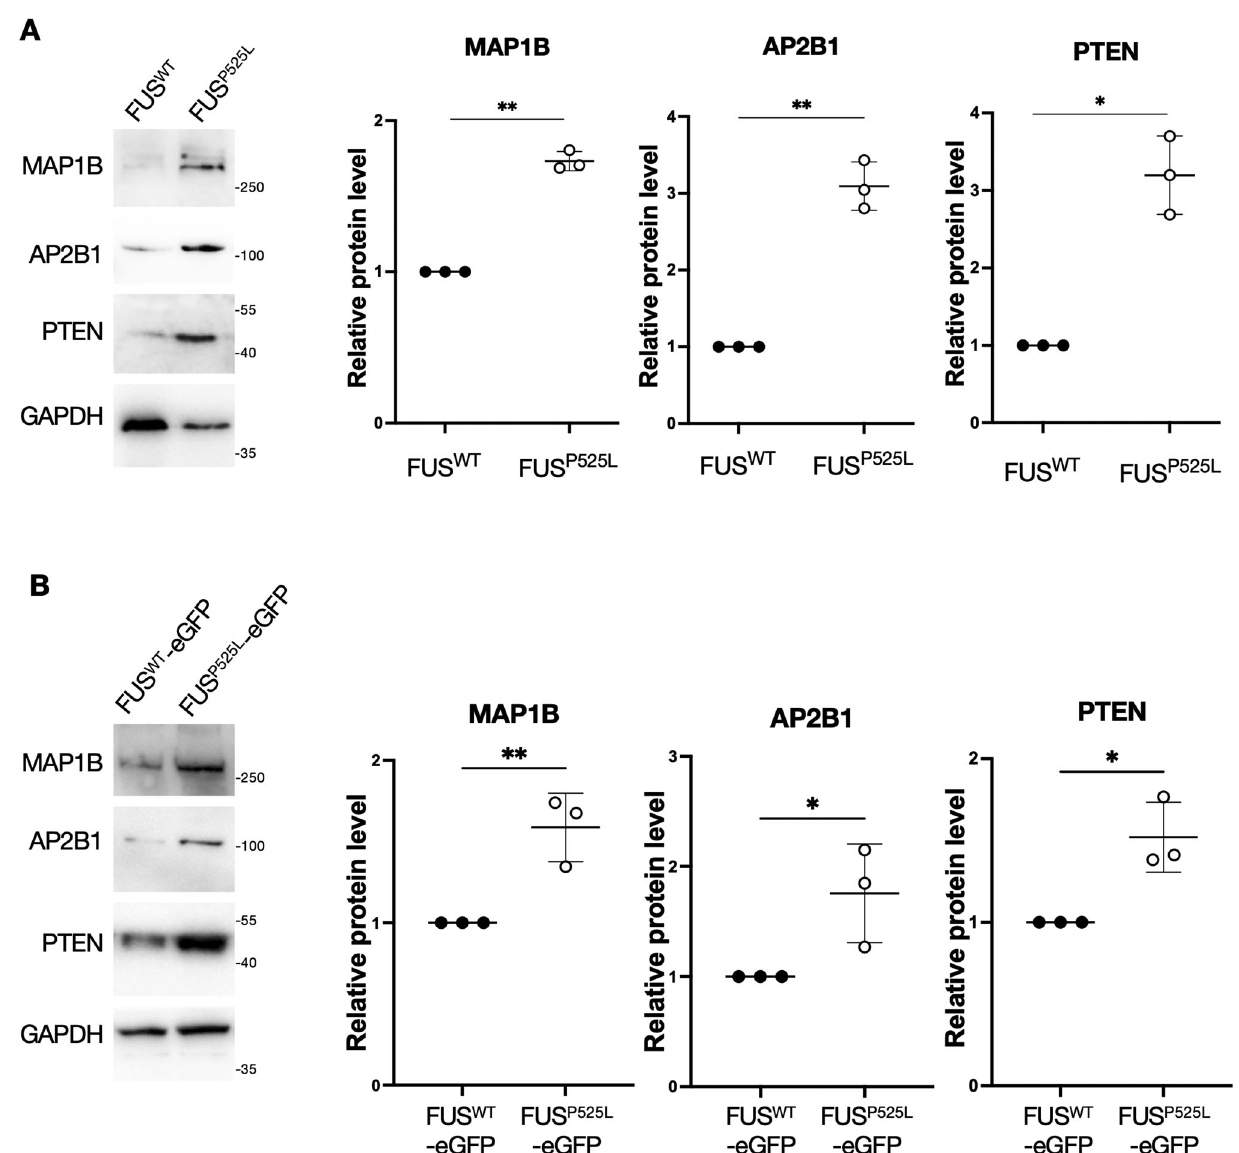
Fig. 7 AP2B1, PTEN, and MAP1B protein levels are increased in FUS mutant MNs. A Western blot analysis of the indicated genes protein levels in FUS WT and FUS P525L iPSC-derived spinal MNs. The molecular weight (kDa) is indicated on the right. The graphs show the average from three independent differentiation experiments, error bars indicate the standard deviation (Student ’ s t -test; unpaired; two tails; * p < 0.05; ** p < 0.01). GAPDH signal was used for normalization. Protein levels are relative to the FUS WT sample for each experiment. B Same analysis as in ( A ), performed in MNs from an independent isogenic pair of wild-type and P525L iPSC lines, in which endogenous FUS is fused at the C-terminal to the enhanced green fl uorescent protein (eGFP) [49]. RNA immunoprecipitation monoclonal anti-human IgG antibody (ab109489; Abcam; RRID:AB_10863040) RNA immunoprecipitation was performed on iPSC-derived MNs with 10µg of as described [21]. An arti fi cial spike RNA in vitro transcribed from the anti-FMRP (ab17722; Abcam, Cambridge, UK; RRID:AB_2278530) or rabbit pcDNA3.1 plasmid was added to the samples before extraction.